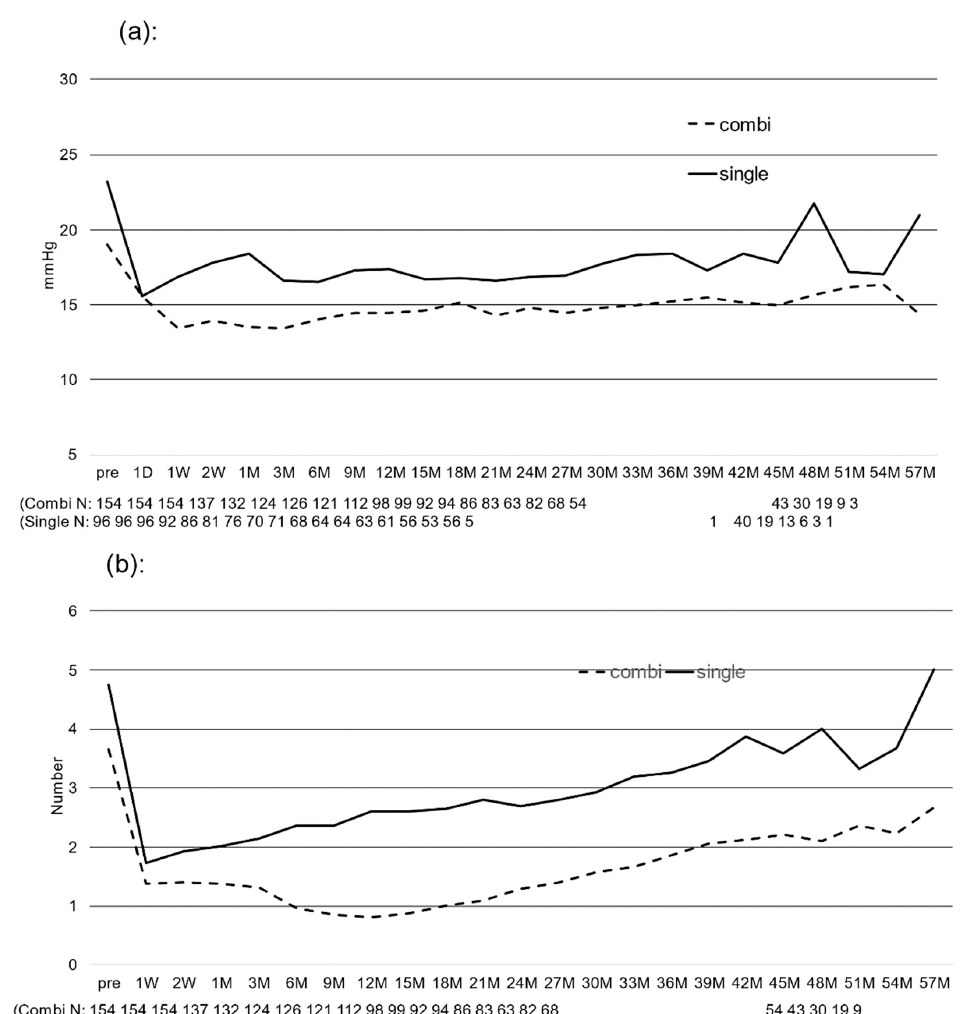
Figure 6. Postoperative changes in ( a ) IOP and ( b ) the number of medications between single vs. combination with cataract surgery. ( a ) IOP significantly decreased from the day after surgery to 48 months postoperatively in the combined cataract group and significantly decreased from the day after surgery to 45 months postoperatively in the trabectome ® alone group ( p < 0.05). ( b ) The number of glaucoma drugs also significantly decreased from 1 week to 51 months postoperatively in the combined cataract surgery group and from 1 week to 39 months postoperatively in the trabectome ® alone group ( p < 0.05).